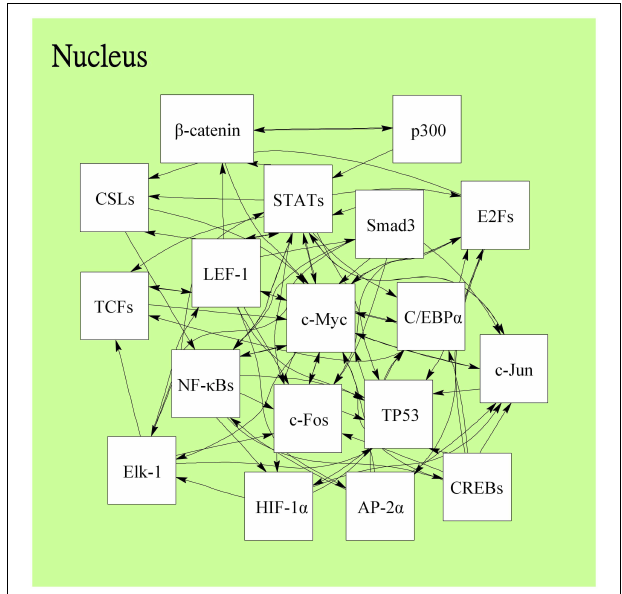
FIGURE 4 | The information flow in the gene regulatory network related to leukemogenesis in the downstream of coupling signal transduction pathways in Figure 3. Each TF regulates other genes and acts as a gene of TF regulated by other TFs. The 18 leukemogenesis-related TFs and the regulations are determined by the TRANSFAC gene-regulation database and shown as follows: AP-2 α , β − catenin , C/EBP α , p300, c-Myc, CREBs (ATF-4/CREB1/Luman/OASIS/CREB3L2/CREB-H/ AIBZIP/CREBPA), CSLs(RBP-JK/RBPJL), E2Fs (E2F1/E2F2/E2F3), Elk-1, c-Fos, HIF-1 α , c-Jun, LEF-1, NF- κ Bs (NF- κ B1/NF- κ B1-p50/NF- κ B2-p52, NF- κ B2/ NF- κ B2-p52/c-Rel/RelA-p65/RelB), Smad3, STATs (STAT1/STAT3/STAT5),